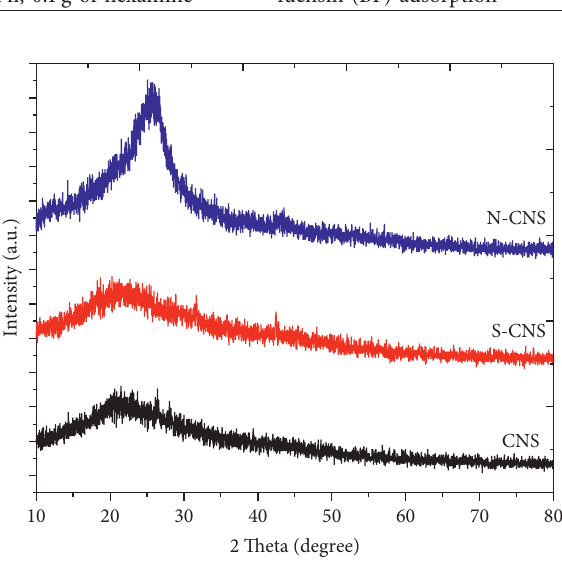
Figure 2: XRD pattern of CNs, S-CNs, and N-CNs.